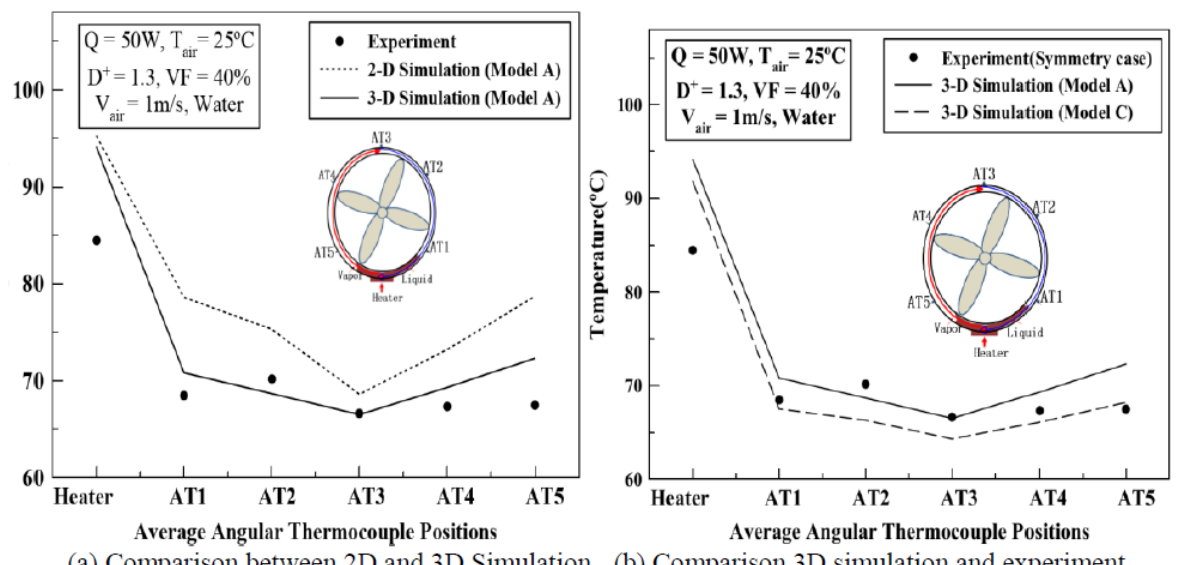
Figure 19. Average Angular Temperature Profile.